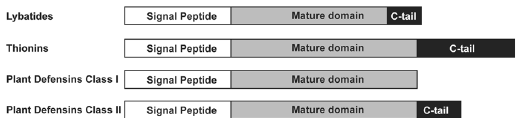
Figure 7. Precursor gene structure organization of lybatides. ( A ) Predicted precursor structure of lybatides based on homologous sequences. A signal peptide followed by the mature domain and a C-tail of about 12–15 amino acids. ( B ) Precursor structure of thionins, where the mature domain is flanked by the signal peptide and an acidic C-tail. ( C ) Precursor structure of the plant class I defensins. They do not contain the C-tail domain ( D ) Precursor structure of the plant C8 class II defensins. They have a similar three-domain organization as lybatides and